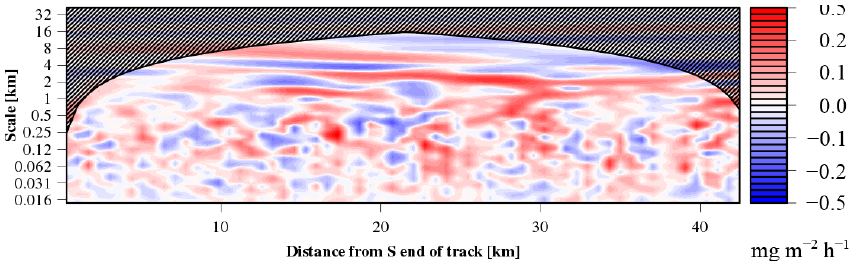
Figure 10. Wavelet cross scalogram of the CH 4 flux equivalent to a time ( x -axis) frequency ( y -axis) resolved version of EC. For each combination of aircraft position and eddy size, blue and red areas indicate transport toward and away from the surface, respectively.